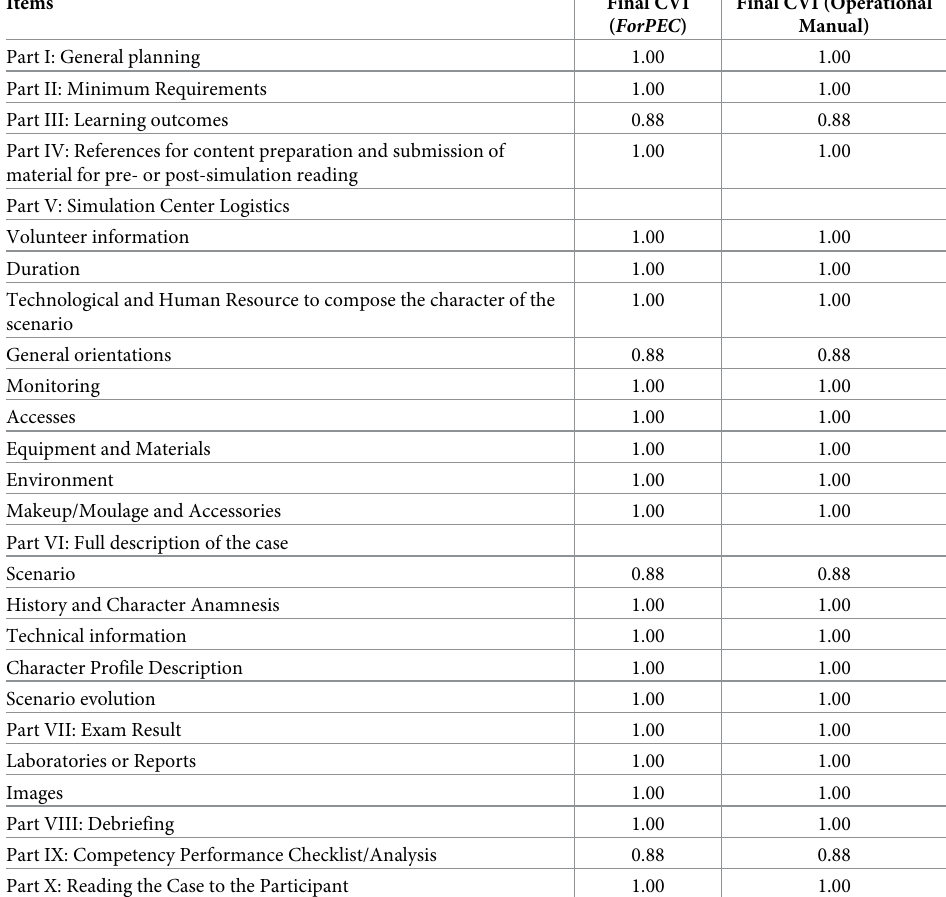
Table 3. Expert agreement on the scope of each part of the ForPEC and the Operational Manual (n = 8). Brazil, 2018. Items Final CVI